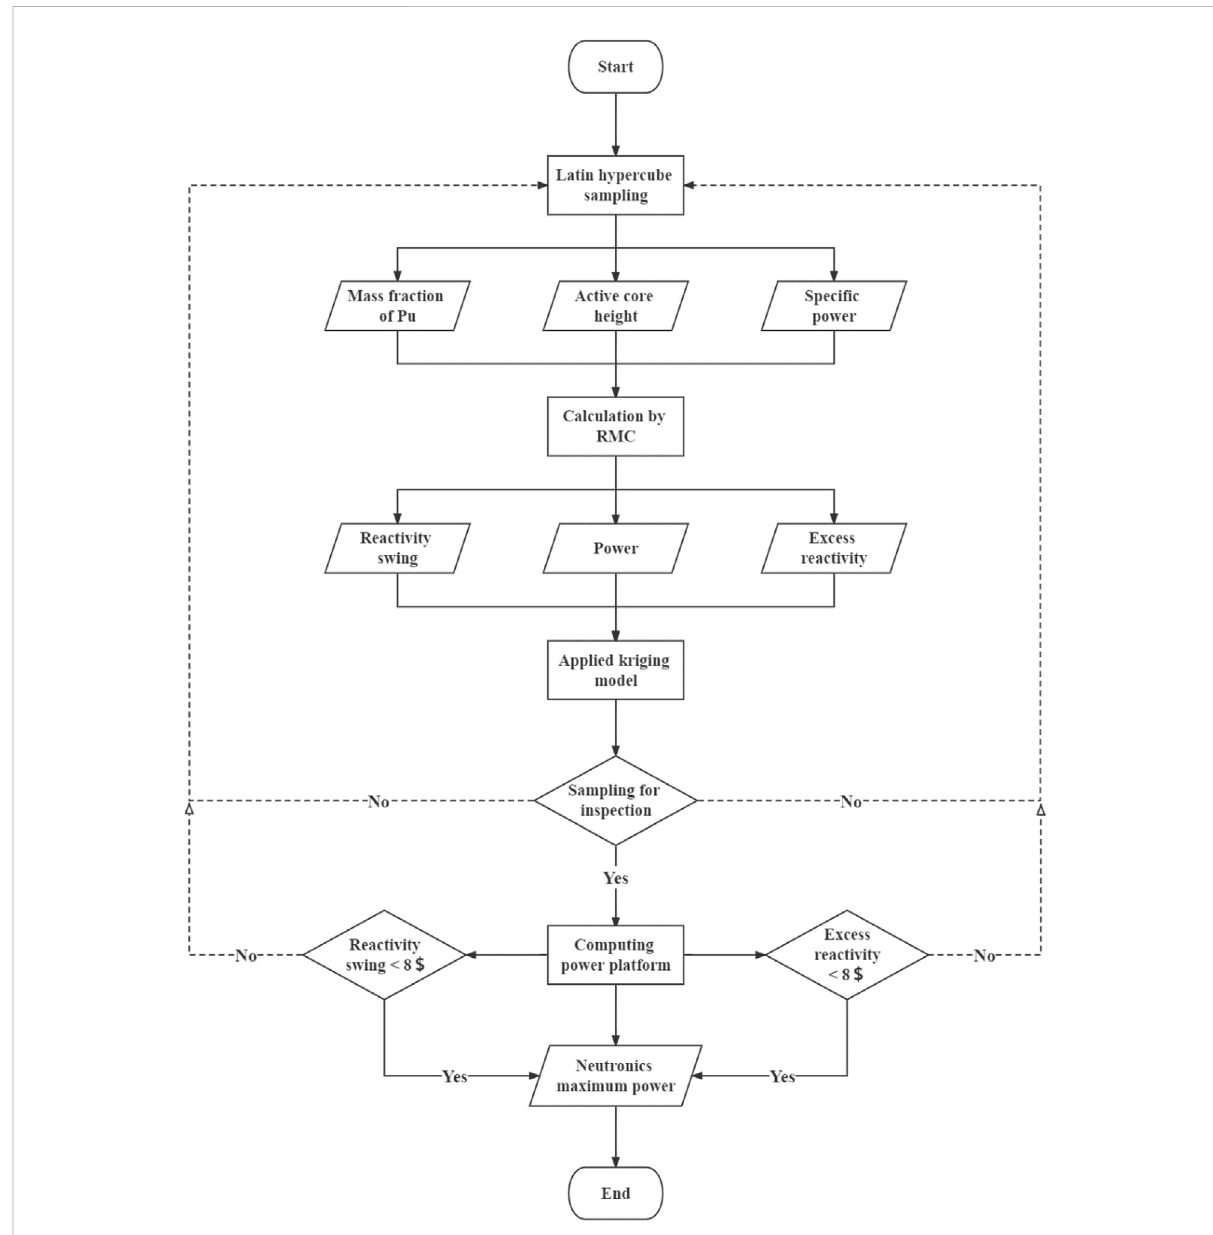
FIGURE 3 Flow chart of the platform used to calculate the maximum neutronic